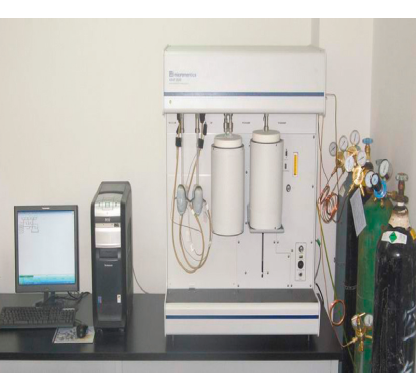
Figure 5: ASAP2020 specific surface microanalyzer.